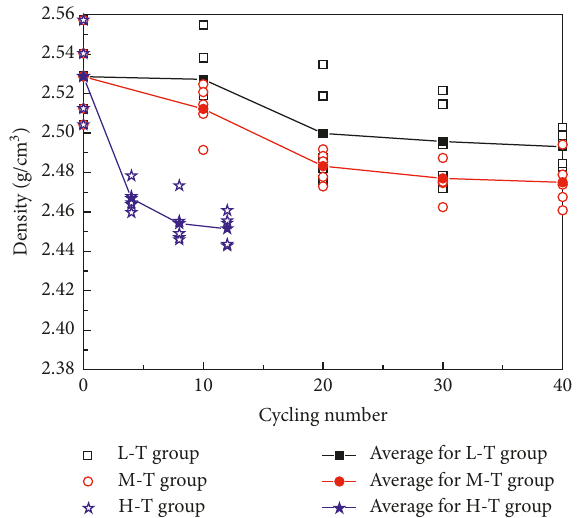
Figure 6: Variation of density of sandstone versus H-C cycles.